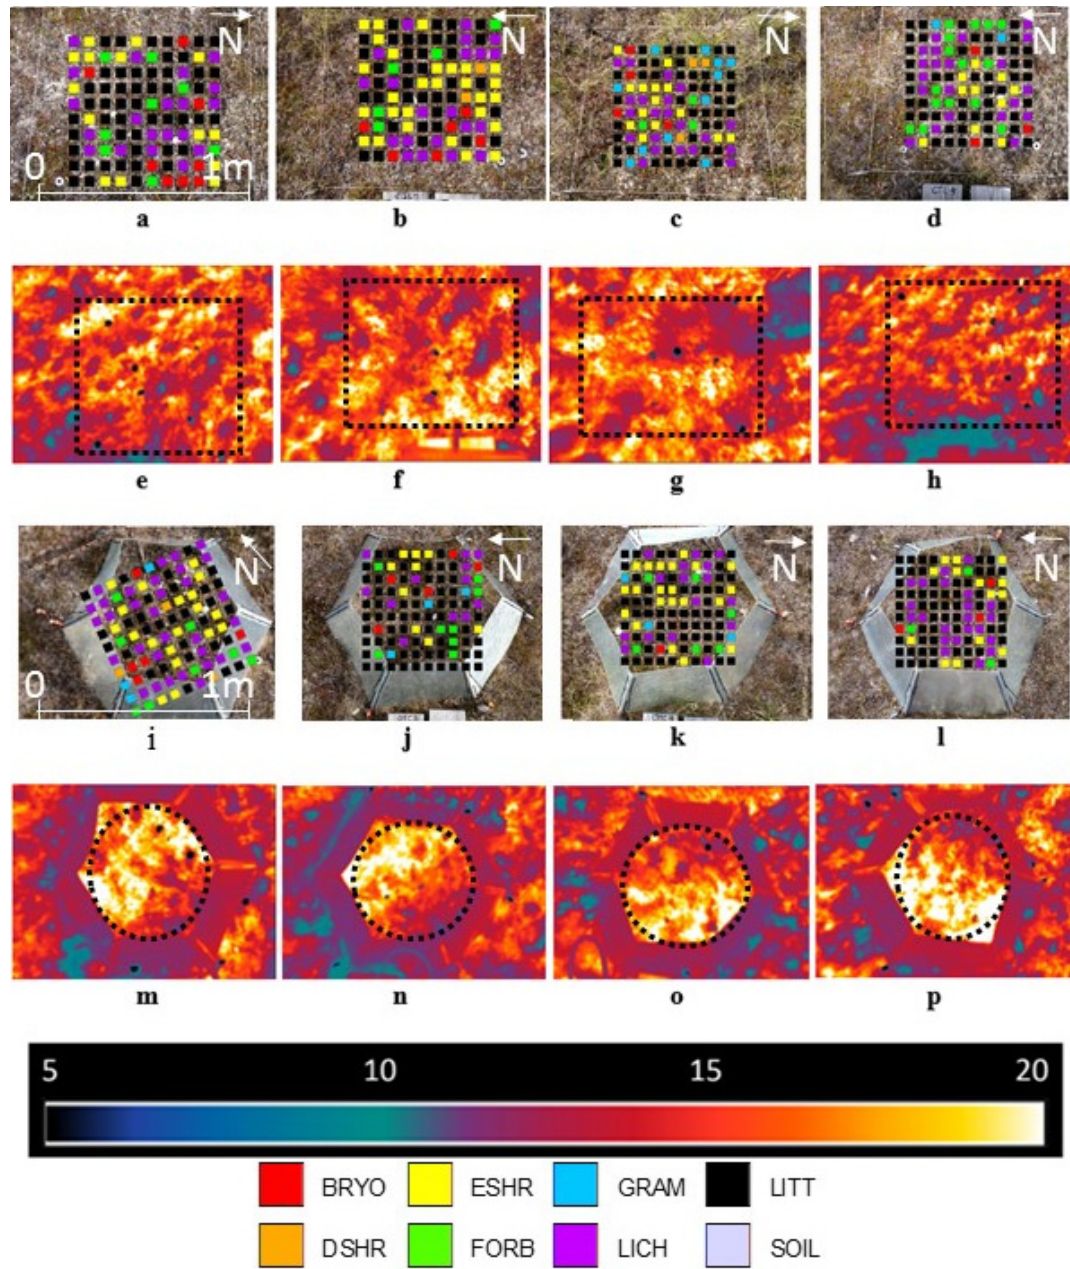
Figure 5. Images depicting four Atqasuk dry site plots ( a – d ) and the coinciding thermal images below ( e – h ); and images of four additional plots ( i – l ) with coinciding thermal images below ( m – p ). Areas of image analysis are outlined with dotted black lines. All temperatures are in degrees Celsius. Plant growth forms and surface features are depicted with the following abbreviations—BRYO: bryophyte/moss; DSHR: deciduous shrub; ESHR: evergreen shrub; FORB: forb; GRAM: graminoid; LICH: lichen; LITT: leaf litter; SOIL: bare soil/rock.